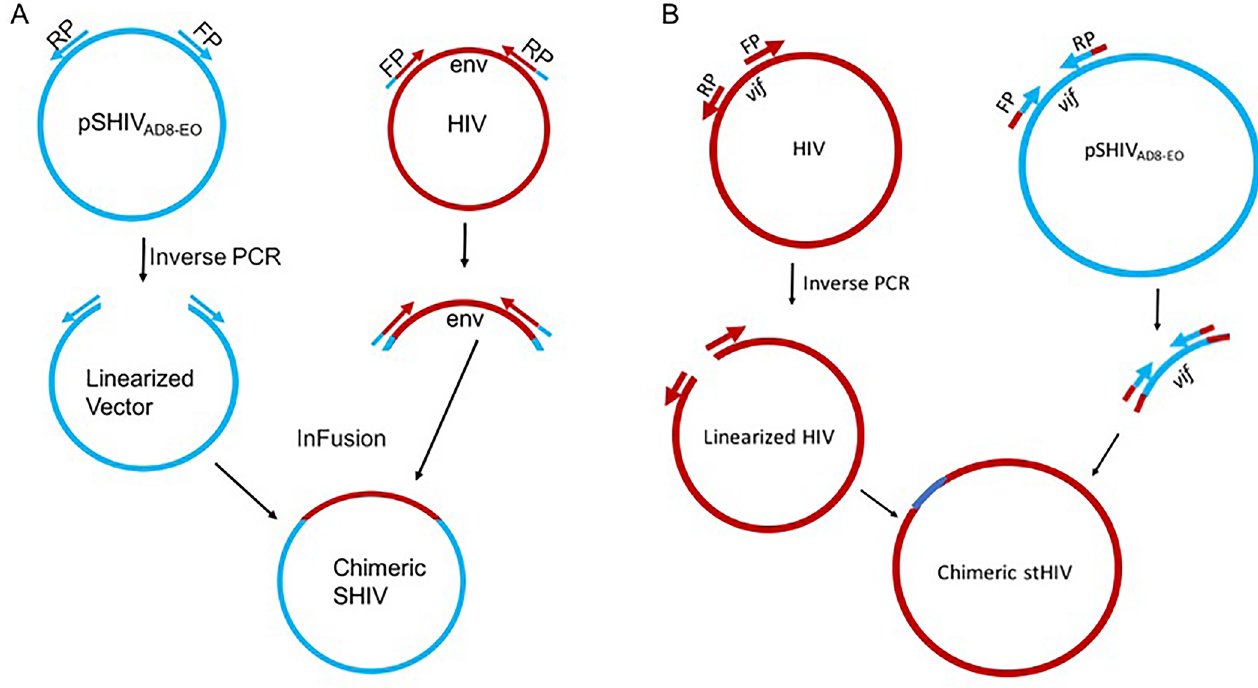
Fig 1. Schematic representation of the In-fusion cloning steps for the generation of (A) Simian Human Immunodeficiency Virus (SHIV) and (B) Simian tropic Human Immunodeficiency Virus (stHIV). Inverese PCR was used for the linearization of the vector backbone, pSHIV AD8-EO. HIV env gene specific primers were used for the amplification of the each env from specific HIV infectious molecular clones as described previously.